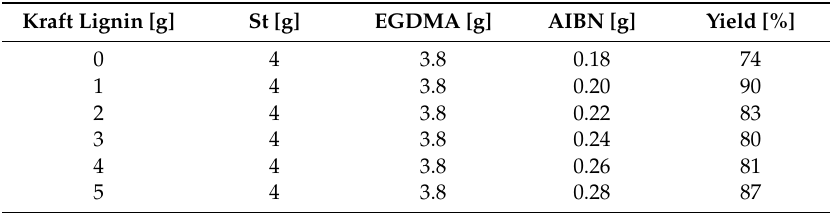
Table 1. Experimental parameters of microspheres